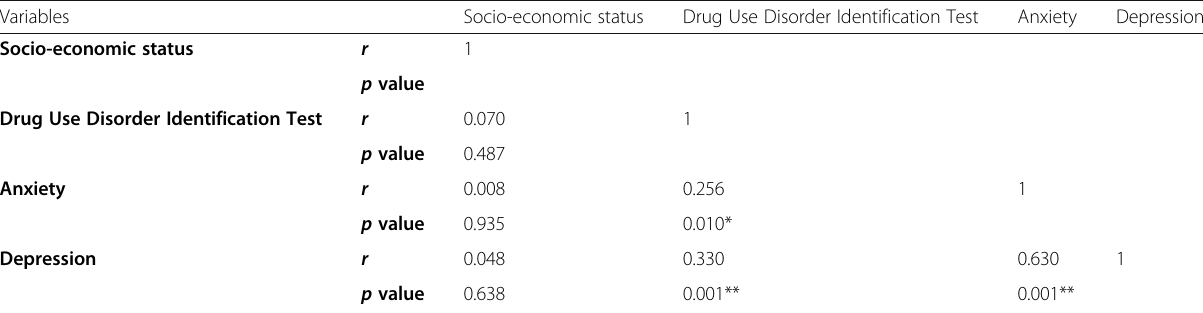
Table 5 Correlation between socio-economic status, Drug Use Disorder Identification Test, anxiety, and depression among SUD patients group ( n =